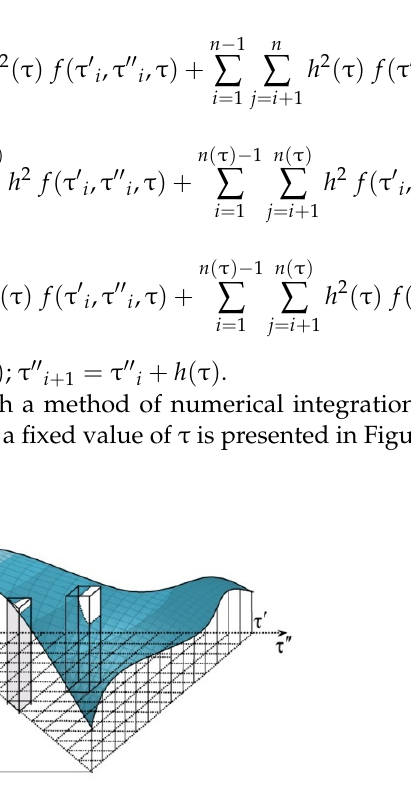
Figure 5. Scheme of numerical double integration with variable upper limits for the fixed τ .